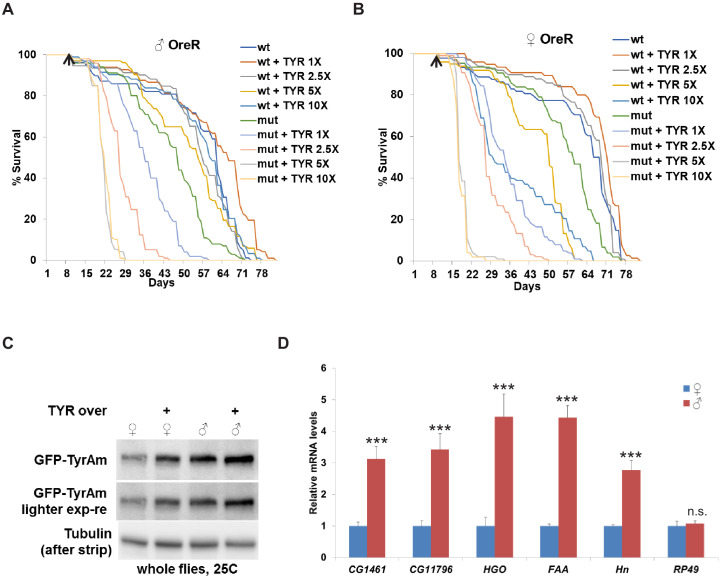
Tyrosine supplementation increases lifespan of wild-type OreR flies and increases expression of GFP-tagged CG1461.Lifespan of male (A) and female (B) wild-type and CG1461-deficient flies (both backcrossed to wild-type OreR flies) fed with the range of tyrosine concentrations (1X = 0.5 g/L). Arrow indicates the beginning of tyrosine feeding. (C) Immunoblot analysis of GFP and tubulin in CG1461(TyrAm)-GFP-tagged flies fed either control or high-tyrosine diet. (D) Relative mRNA levels of CG1461, CG11796, Hgo, Faa, Hn, Rp49 in male and female flies. Means ± SD. Means ± SD. *p<0.05, **p<0.01, ***p<0.001.